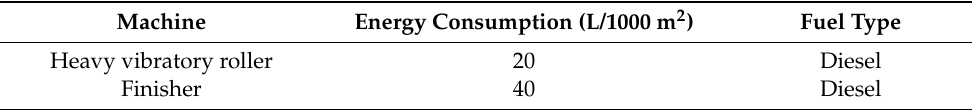
Table 4. The machinery and energy consumption of wearing surface construction stage.